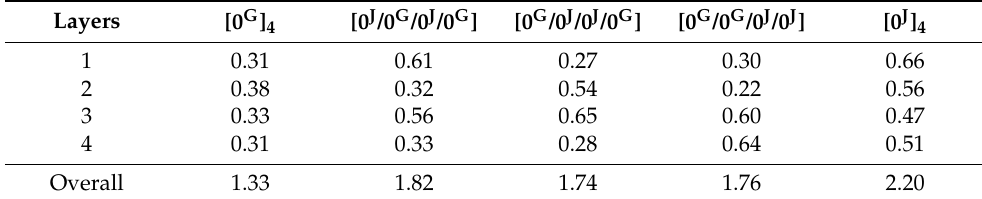
Table 2. Thickness of each layer of the laminates, in mm.